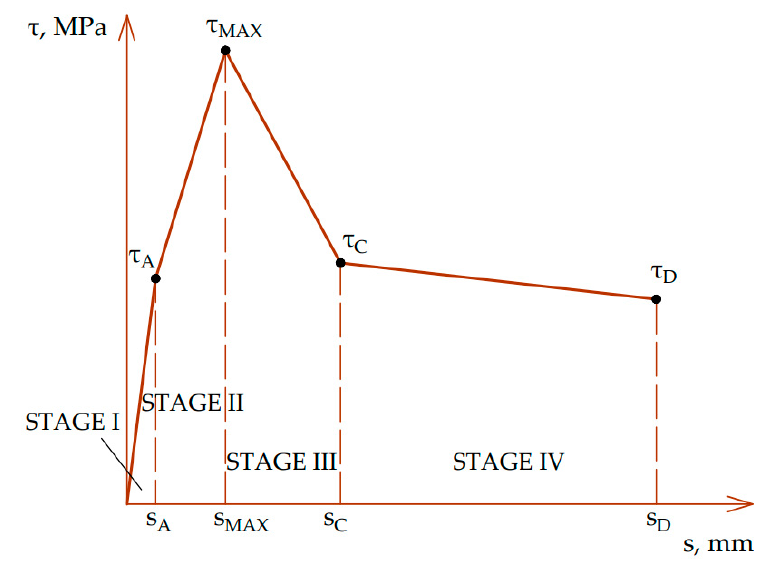
Figure 3. Shear stress—relative slip relationship curve for an interface crossed by connectors.